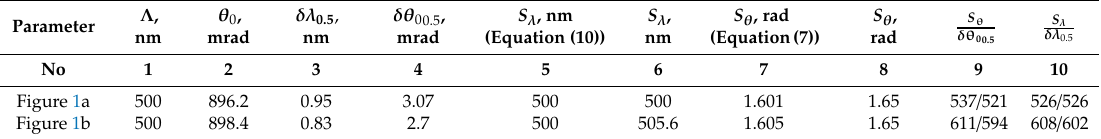
Table 3. Parameters characterizing the sensitivity of both grating types compared to the change of the refractive index of the test